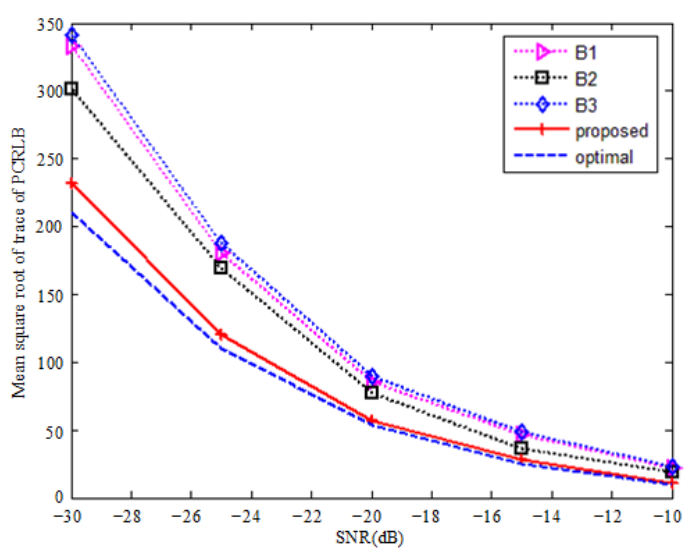
Figure 8. Mean square root of trace of PCRLB.